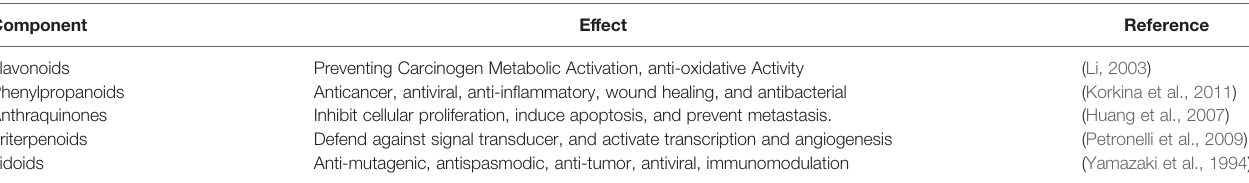
TABLE 1 | Effects of the components from Lian Hua Qing Wen capsule (LHQW) capsule.